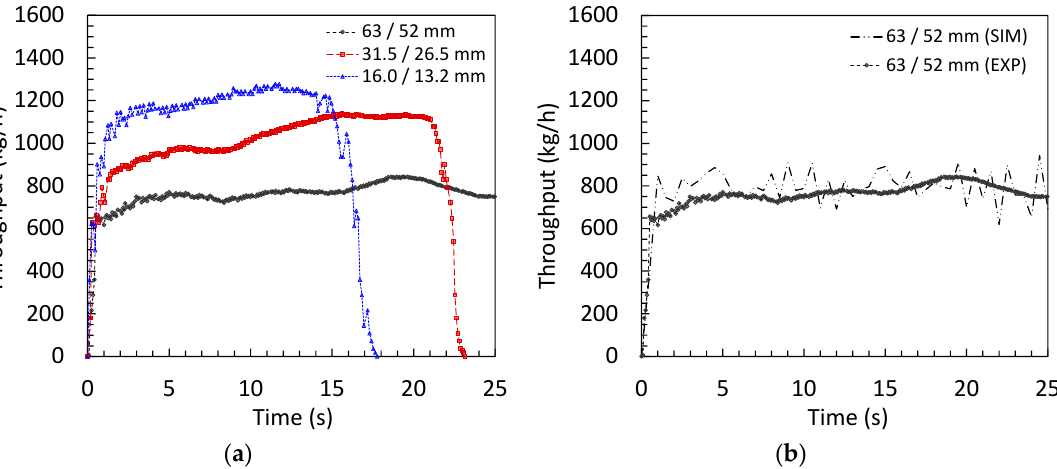
Figure 13. Experimental ( a ) and DEM simulations and experiment ( b ) of the laboratory jaw crusher throughput.